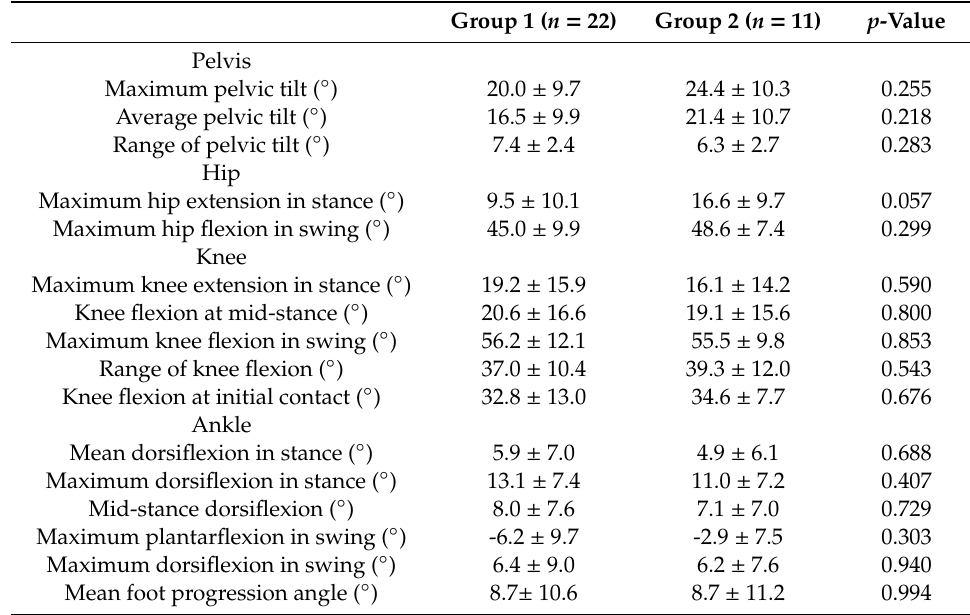
Table 5. Comparisons of postoperative kinematic parameters between the Groups 1 and